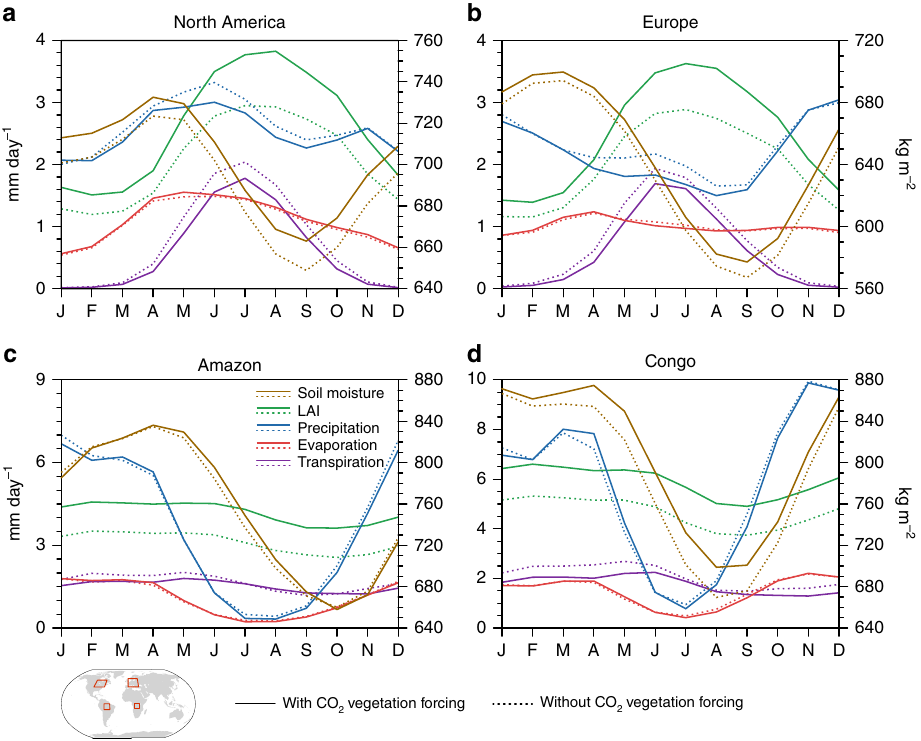
Fig. 5 Annual cycle of vegetation and hydrologic variables in simulations with and without future CO 2 vegetation forcing. CMIP5 multi-model mean area- weighted averages of total-column soil moisture (brown), leaf area index (LAI) (green), precipitation (blue), evaporation (red), and transpiration (purple) for portions of a North America (40°N – 55°N, 100°W – 70°W), b Europe (40°N – 60°N, 0° – 30°E), c the Amazon basin (0° – 15°S, 65°W – 50°W), and d the Congo basin (0° – 10°S, 15°E – 30°E). Dashed (solid) lines represent the fi nal 30 years of the RadCO2 ( TotalCO2 ) simulation. LAI (unitless), precipitation, evaporation, and transpiration correspond to the left y -axis. Soil moisture corresponds to the right y -axis. Output from HadGEM2-ES is not included in the